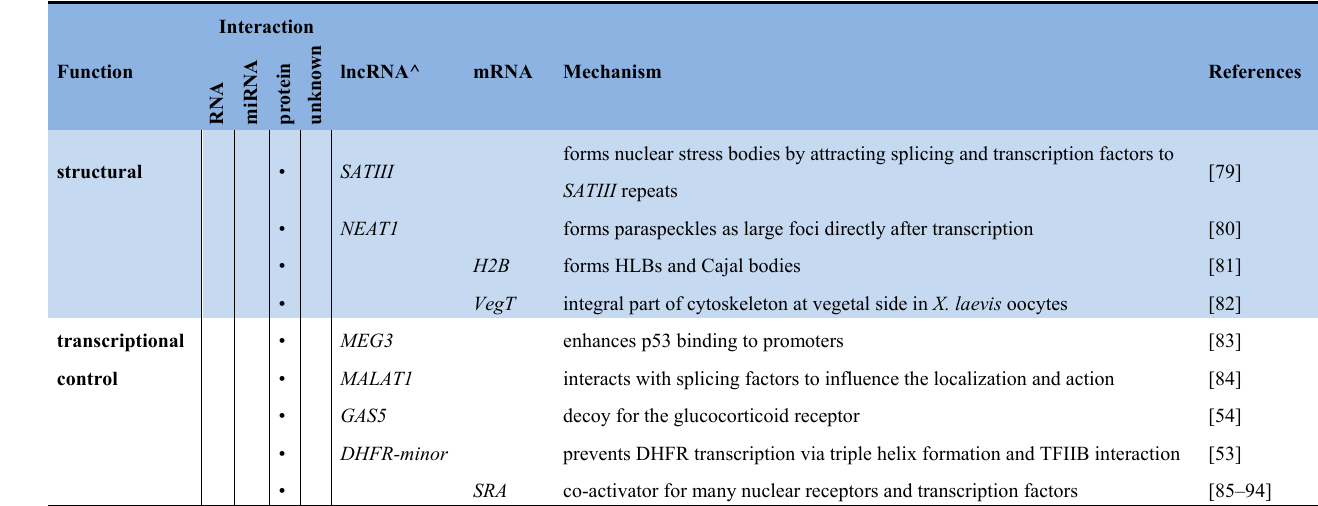
Table 1. Regulatory functions of lncRNAs and mRNA and their type of